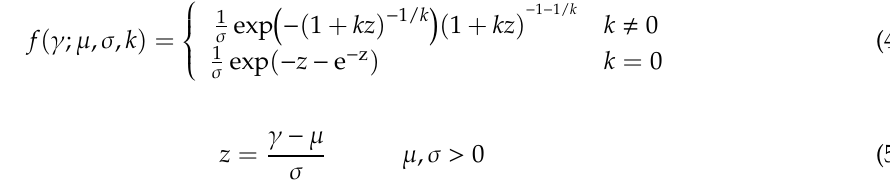
Figure 2e–h is the VH amplitude, VV amplitude, composed pseudo color and the reflection